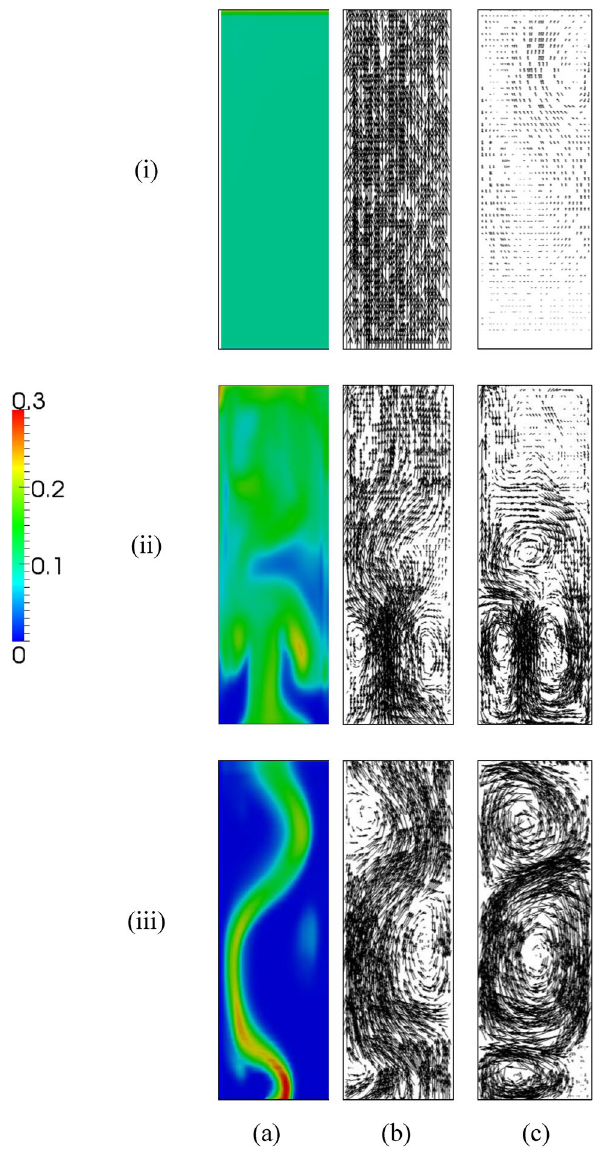
Fig. 6 Simulated a gas volume fraction distribution, b gas veloc- ity vector and c liquid velocity vector using (i) Re based drag for A1 (100%) and (ii and iii) Tsuchiya drag for A4 (69%) and A7 (18%) (U = 2.9 G